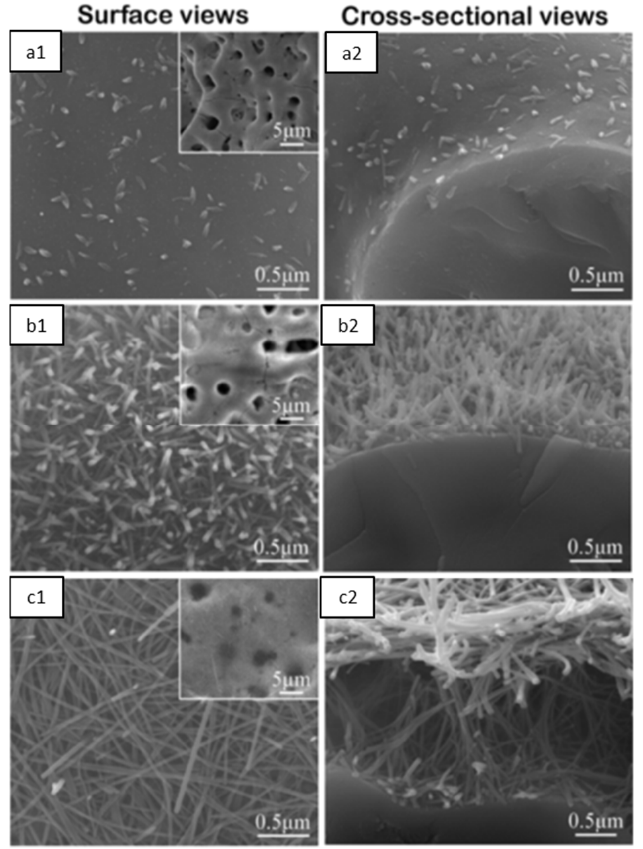
Figure 17. ( a1 – c1 ) Surface and ( a2 – c2 ) cross-sectional SEM images of the outermost parts of the internal walls of macropore, HT for ( a1 , a2 ) 0.5, ( b1 , b2 ) 3, ( c1 , c2 ) 24 h, respectively. Adapted with permission from Ref. [70]. Copyright 2015 Royal Society of Chemistry.